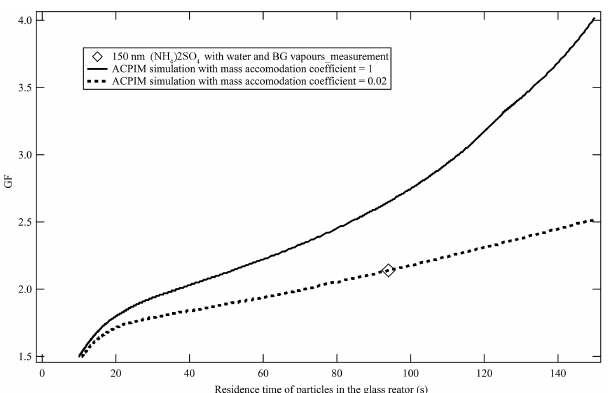
Figure 7. Measured and simulated GF with residence time for (NH 4 ) 2 SO 4 particles exposed to water and BG